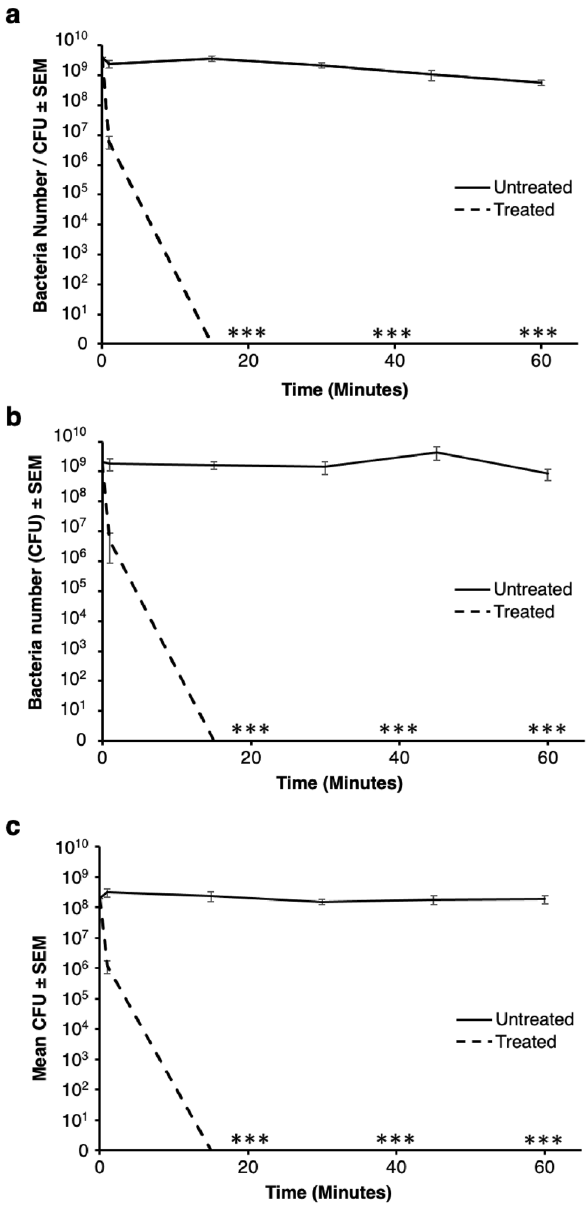
Figure 3. Antimicrobial efficacy of filters. ( a ) Time course showing E. coli survival at different time points following incubation on untreated and CHDG treated MK3 filters. *** denotes statistical significance < 0.001, n = 9. Error bars show standard error of the mean. ( b ) Time course showing MRSA survival at different time points following incubation on untreated and CHDG treated MK3 filters. *** denotes statistical significance < 0.001, n = 9. Error bars show standard error of the mean. ( c ) Time course showing C. albicans survival at different time points following incubation on untreated and CHDG treated MK3 filters. *** denotes statistical significance < 0.001, n = 9. Error bars show standard error of the